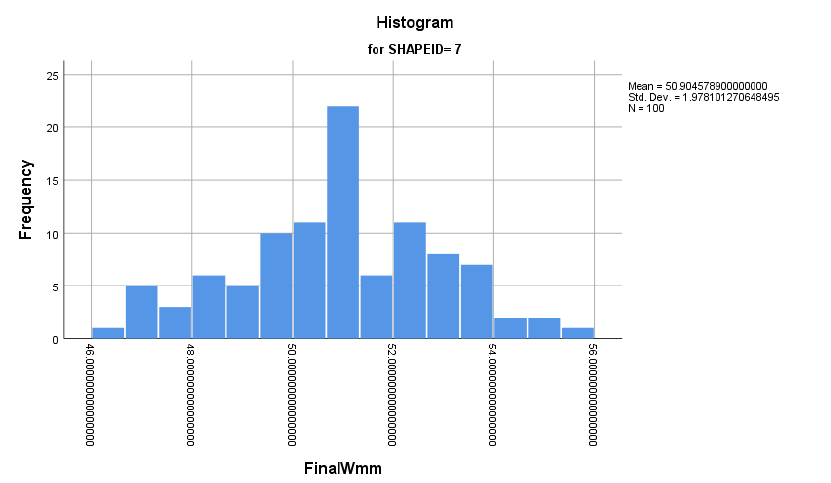
Figure A15. Shrink width adjustment for 50 mm.